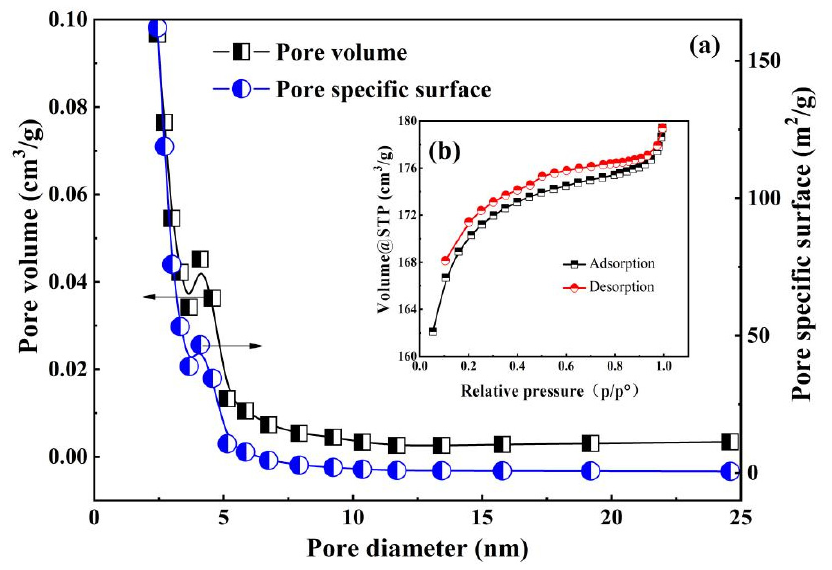
Figure 2. Pore size and volume accumulation curves ( a ) and ( b ) nitrogen adsorption–desorption isotherm of CDBPC.